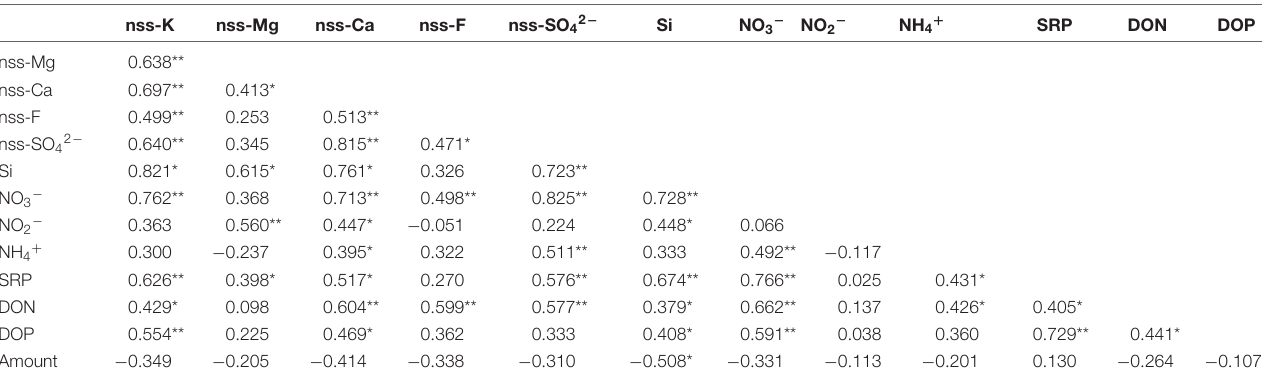
TABLE 2 | Coefficients from Spearman’s rank correlation tests between non-sea salt fraction of major ions and nutrients, as well as precipitation amount (mm) in rainwater.